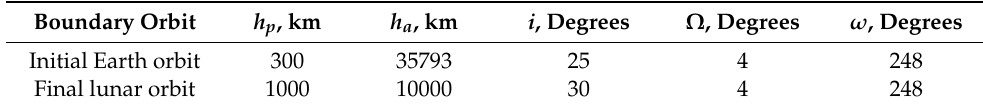
Table 4. Parameters of the initial GTO and final elliptical lunar orbit.